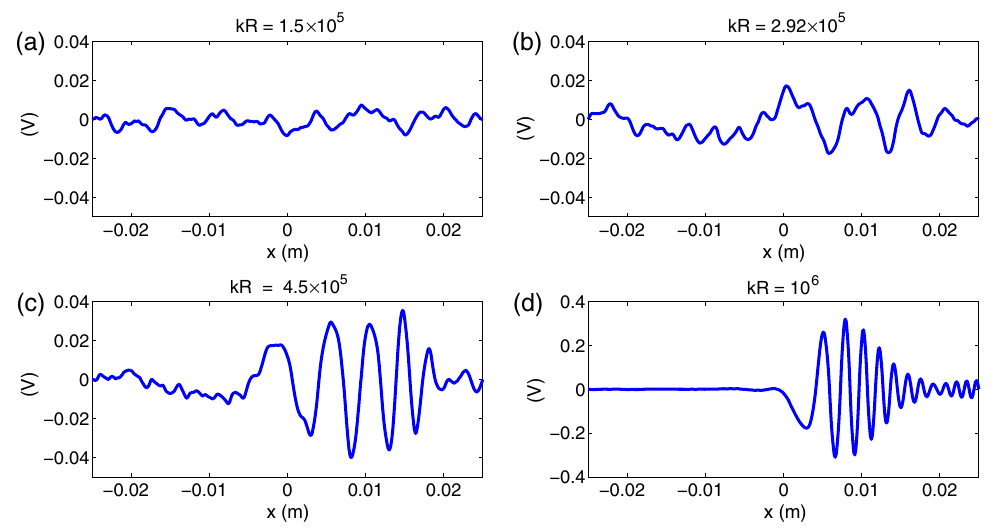
ˆ E k; s; x Þ vs. x for s ¼ 0 . 55 m at the end of the bend, p ¼ 9 , comparing values of kR around the shielding cutoff at FIG. 14. sp ð kR ¼ 2 . 92 × 10 5